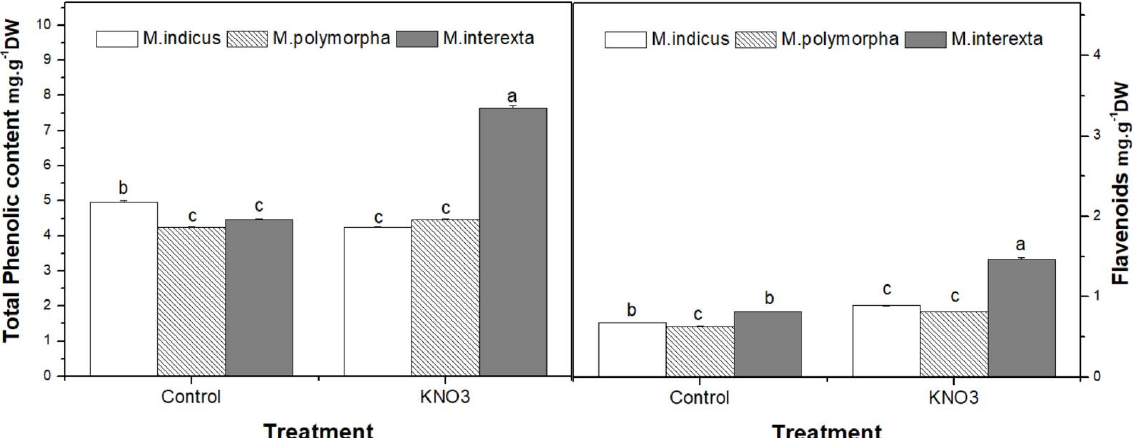
Figure 2. Effect of KNO 3 priming on total phenolic and flavonoid contents of three species of Medicago sprouts. Values are represented by mean ± standard deviation of at least three independent replicates. Within the same species, different letters on the bars indicate significant differences at p < 0.05. Besides, KNO 3 priming enhanced the FRAP activities by 41%, 59%, and 35% for Medi- cago indicus , Medicago polymorpha , and Medicago interexta , respectively, in comparison to control (Figure 3). Furthermore, the reduced ascorbate and glutamine increased signifi- cantly ( p < 0.05) in the three species as response to KNO 3 priming, and the highest increase was recorded in Medicago interexta (Figure 3) .